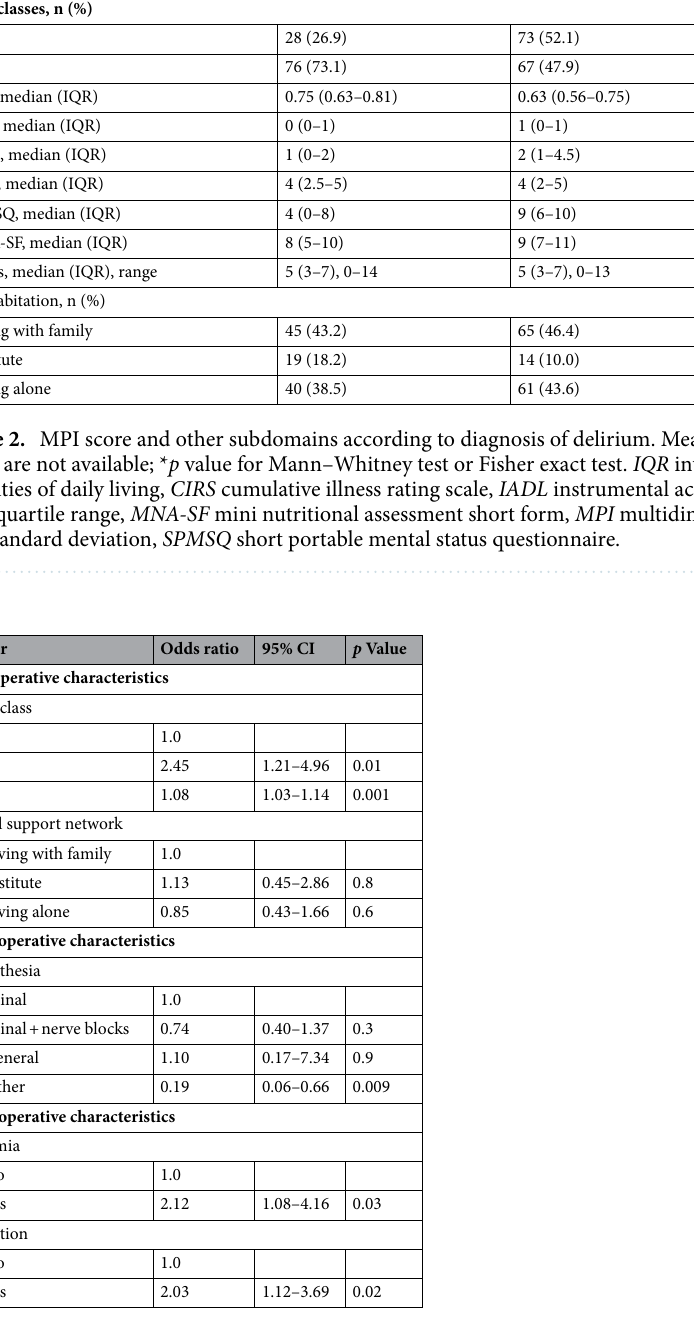
Table 3. Multivariate logistic model for the diagnosis of pre-operative delirium. Odds ratios are also adjusted for gender, waiting time for surgery and number of drugs. CI confidence interval.